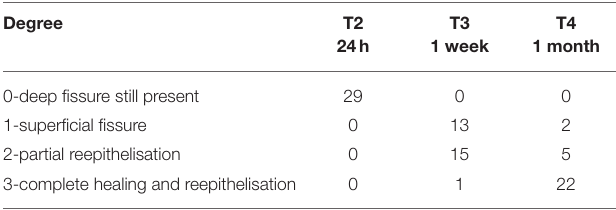
TABLE 6 | Degree of